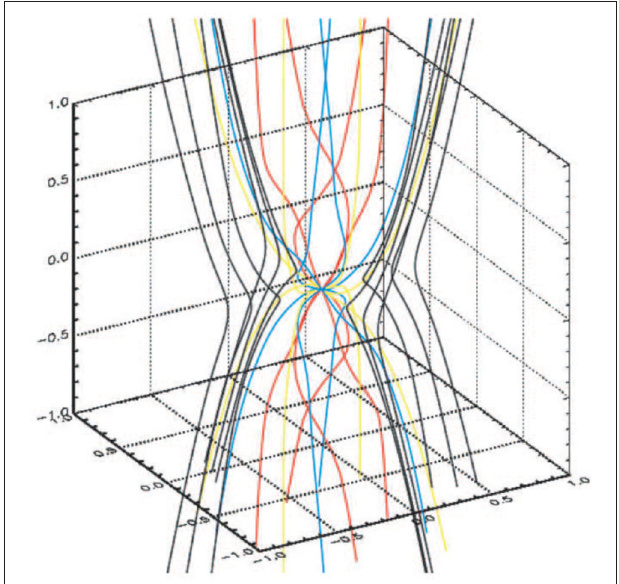
FIGURE 1 | A model from Allen et al. (2003) showing an hourglass-shaped magnetic field configuration in a collapsing, magnetized star-forming core. Reproduced with permission from the American Astronomical Society